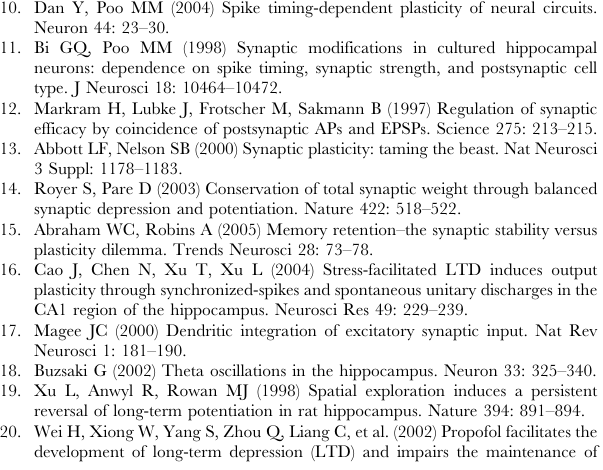
Figure S4 Commissural activity is required for spatial